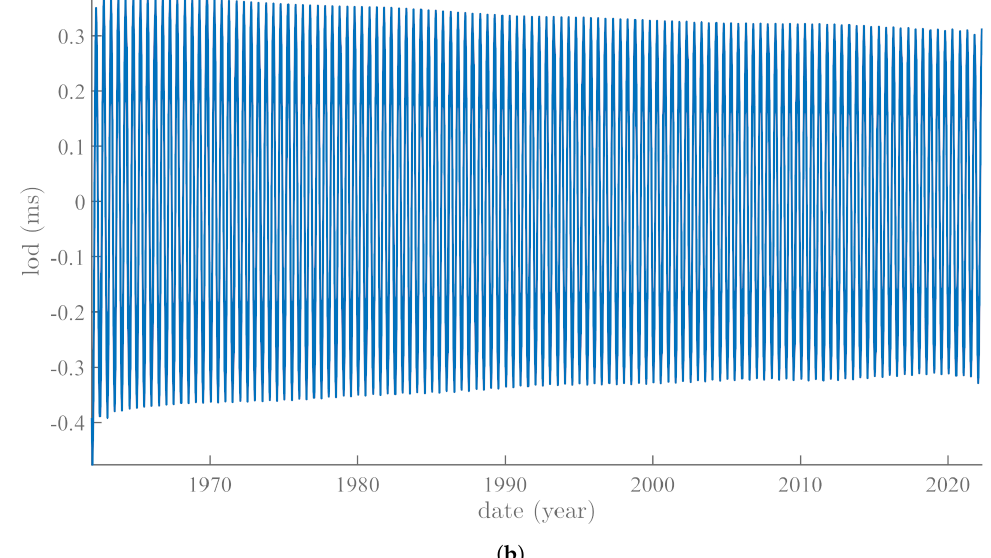
Figure 2. Annual and semi-annual components extracted from length of day: ( a ) iSSA annual component of length of day from 1850 to the present; ( b ) same as ( a ) but for the semi-annual component.